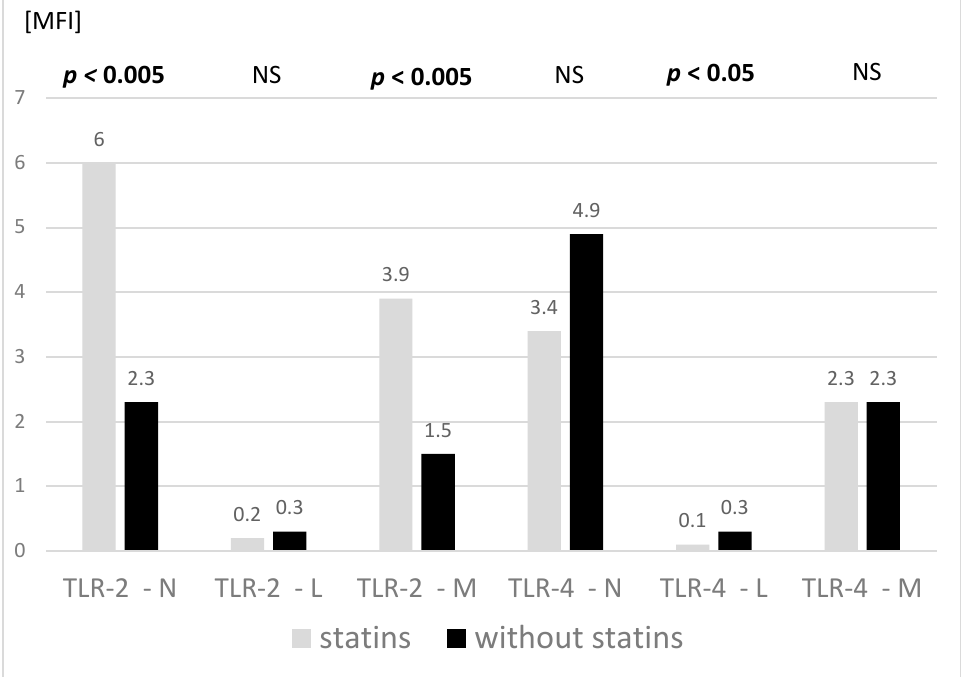
Figure 2. Expression of TLR-2 and TLR-4 on peripheral blood cells in the examined groups (N– neutrophils, L–lymphocytes, M–monocytes). Treated with simvastatin n = 11, not treated with simvastatin n = 9. Mann–Whitney two-sided rank U-test was used. NS: not significant. MFI: Mean fluorescence intensity.